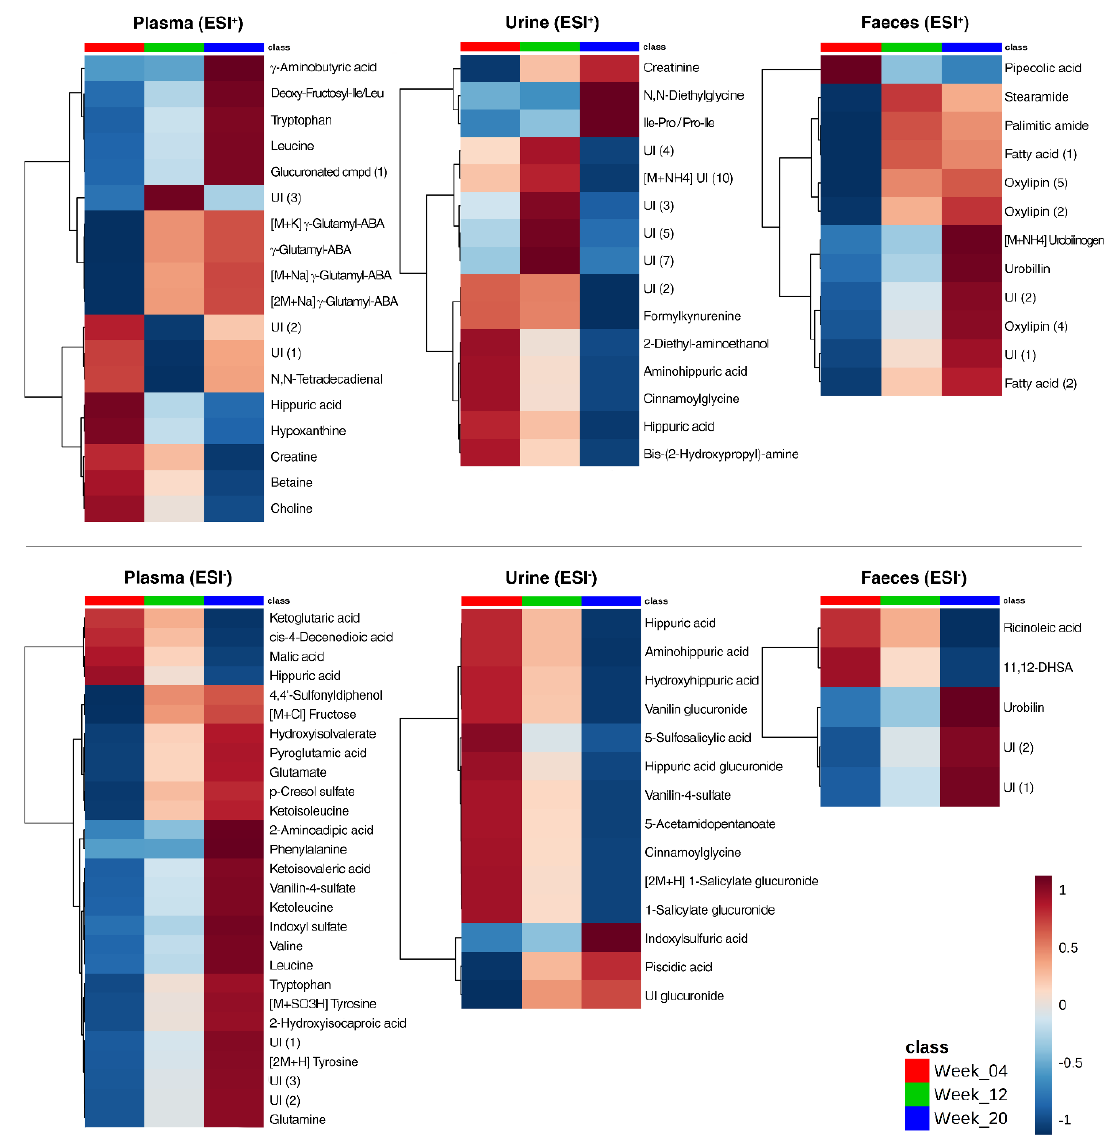
Figure 9. Heat map of metabolites discriminating ( p < 0.05) between the weeks of dietary intervention in plasma, urine, and feces of Göttingen Minipigs analyzed in positive (ESI + ) and negative (ESI − ) ionization mode, presented as individual means per class group. Abbreviations: cmpd, compound; UI, unidentified; γ -glutamyl-ABA, γ -glutamyl-aminobutyraldehyde; 11,12-DHSA, 11,12-dihydroxystearic acid.